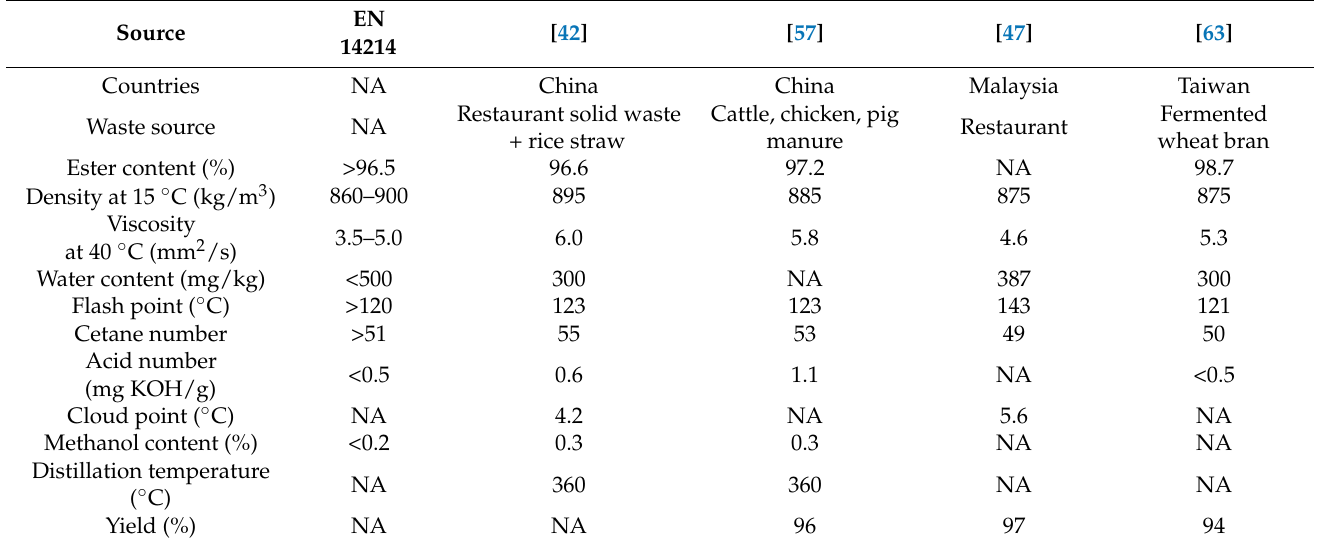
Table 4. Summary of characteristics of biodiesel produced from BSFL in Asian countries. EN 14,214 indicates the require- ments and test methods for fatty acid methyl esters (FAME) organized by the European committee for standardization. Yield (%) refers to the percentage of biodiesel converted from the lipids produced by BSFL. NA: Not